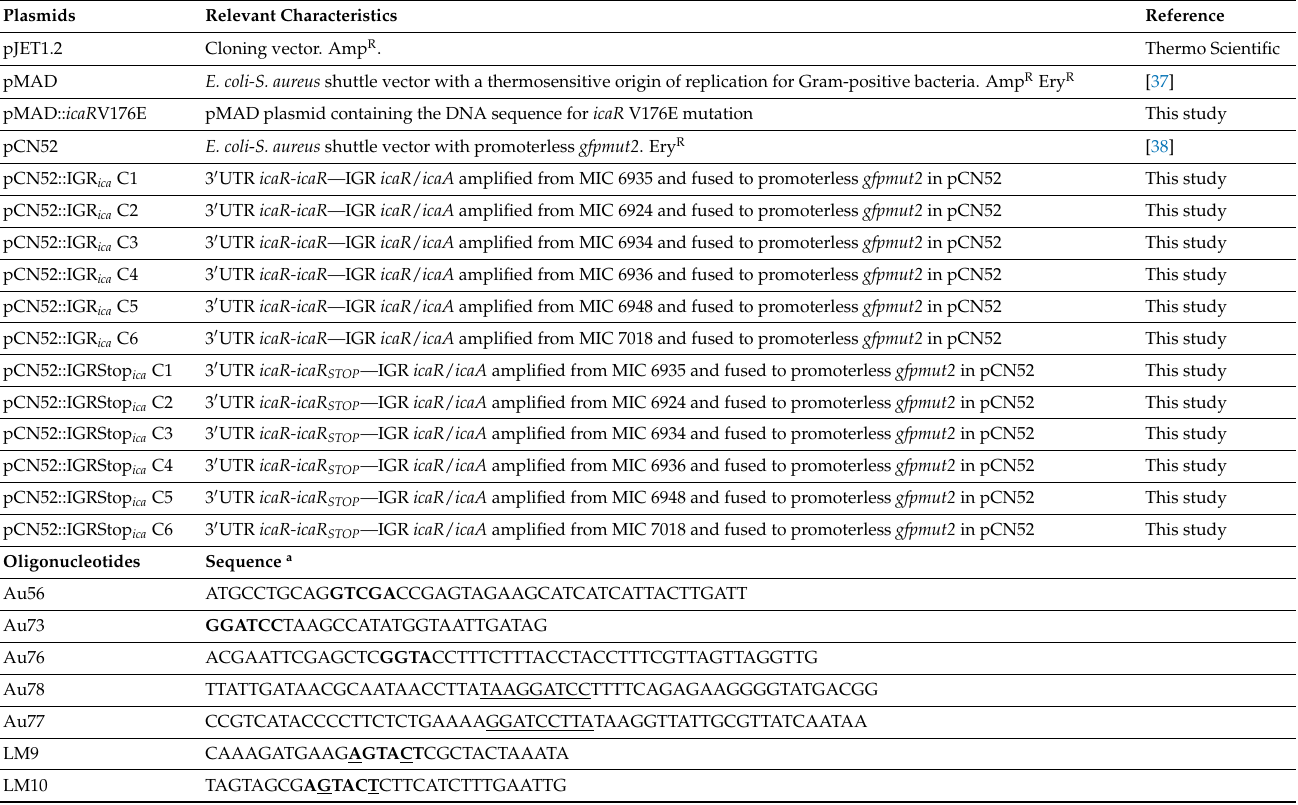
a : Restriction enzymes sites and nucleotides for gene editing are indicated in bold and underlined,